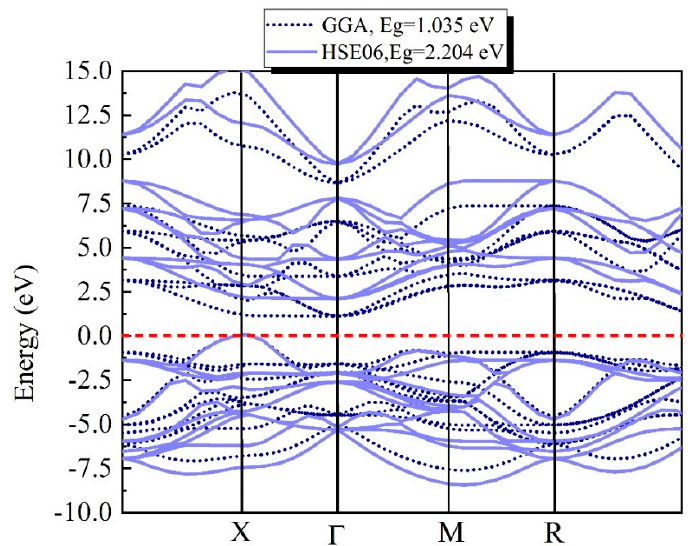
Figure 2. Electronic band structures of perovskite SnTiO 3 as calculated with the GGA and HSE06 approaches.